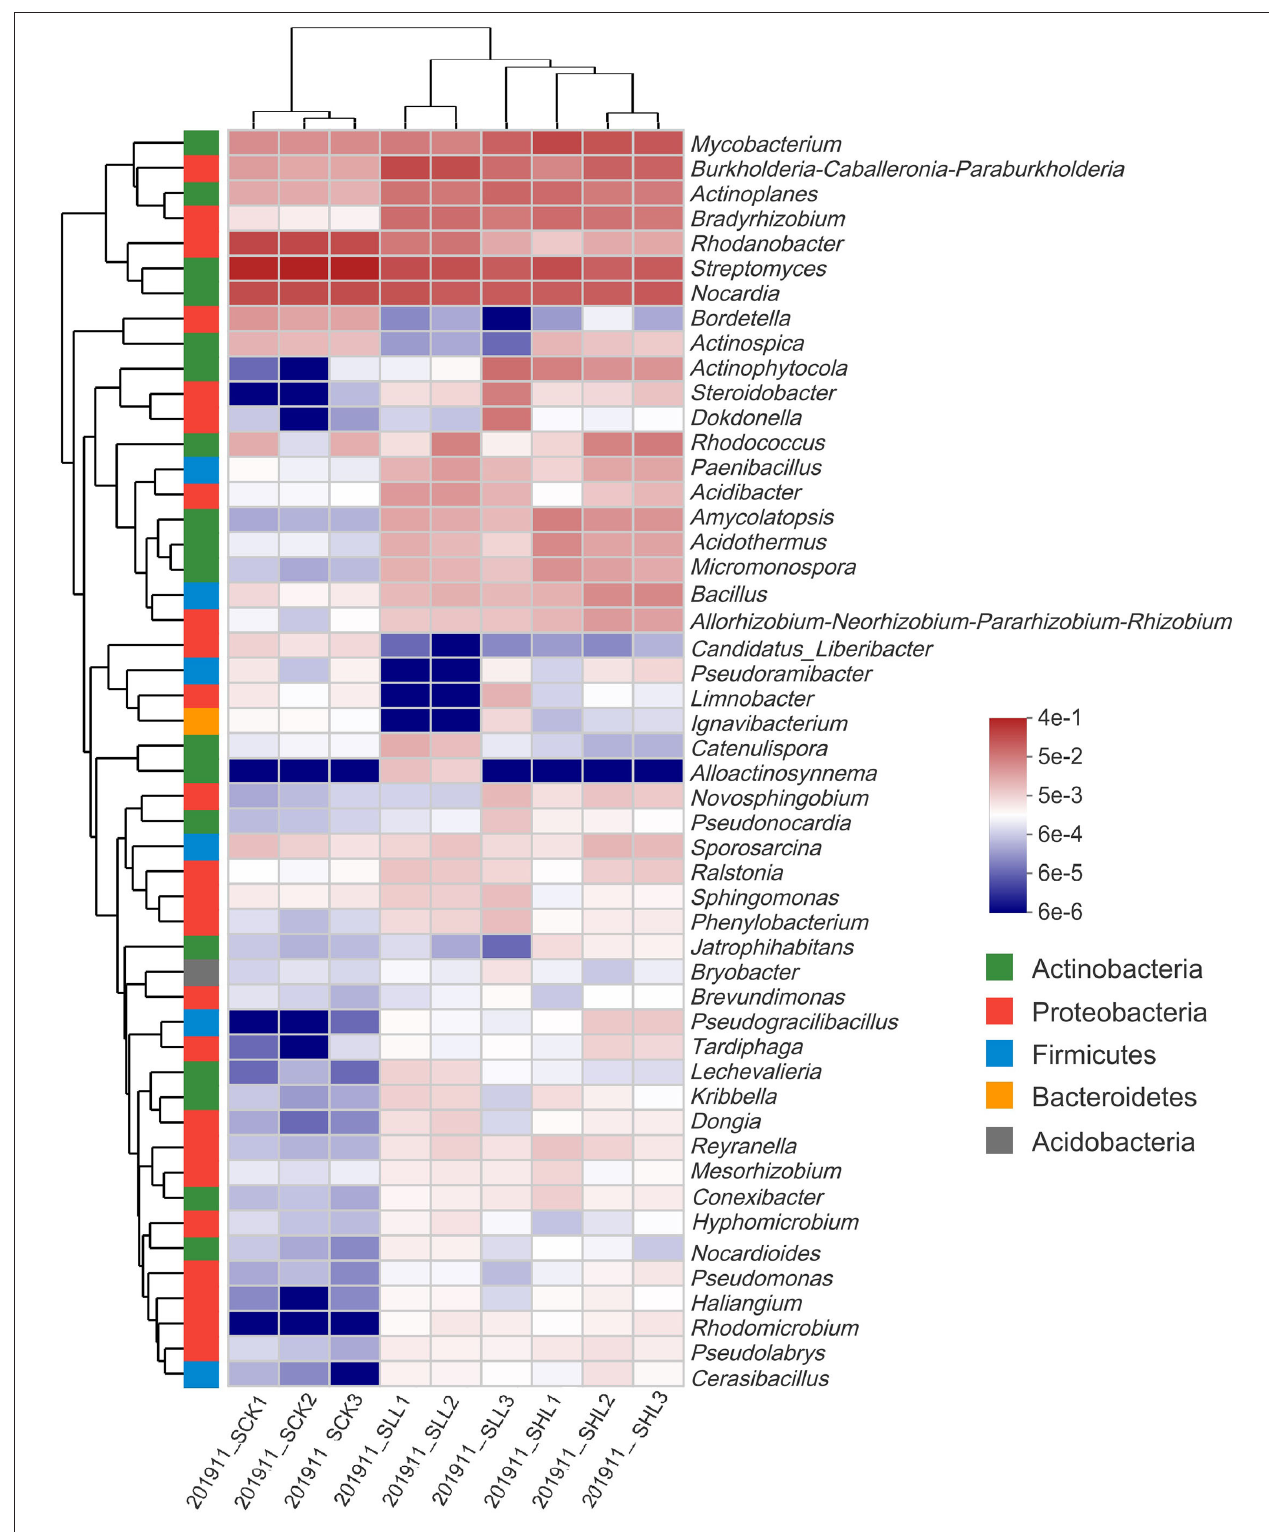
FIGURE 2 | Heatmap for the relative abundance of the 50 most abundant core genera in HLB-infected citrus root samples based on 16S amplicon sequencing. SCK, soil without lime treatment; SLL, soil treated with low-level lime; SHL, treated with high-level lime.